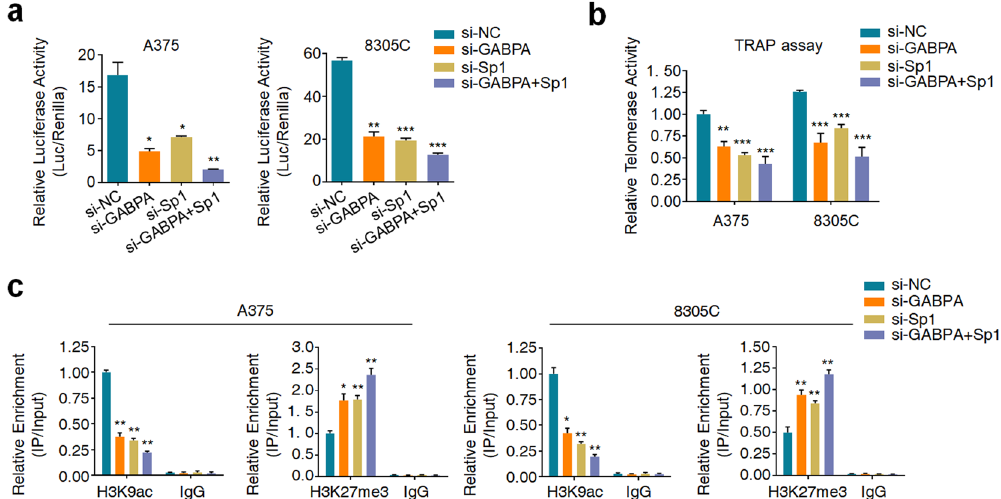
Fig. 6 Synergistic activation of mutant TERT promoter by Sp1 and GABPA. a In vitro luciferase assay was performed to determine synergistic effect of GABPA and Sp1 on the activity of mutant TERT promoter in the indicated cells. b TARP assay was performed to determine the synergistic effect of GABPA and Sp1 on TERT reactivation. c ChIP-qPCR assay was performed to determine the synergistic effect of GABPA and Sp1 on histone modi fi cations (including H3K9ac and H3K27me3) of TERT promoter in the indicated cells. Data were shown as mean ± SD. * P < 0.05; ** P < 0.01; *** P <